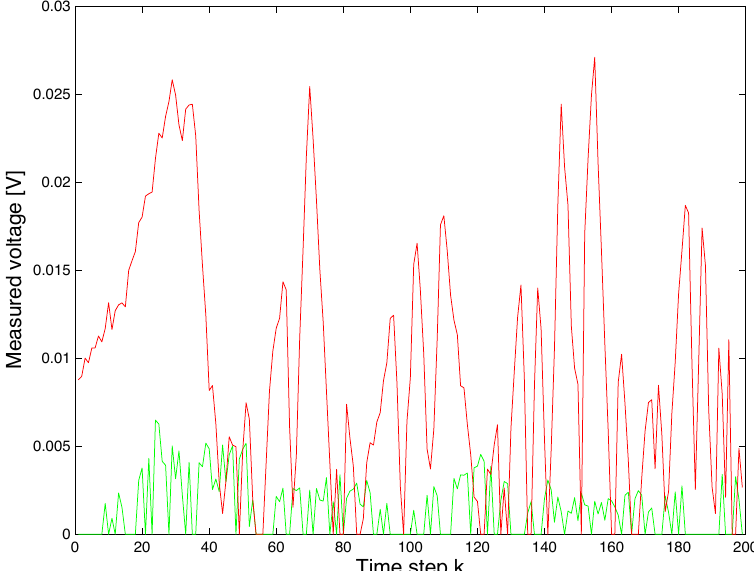
Figure 11. Plot illustrating the minimum voltage that was experimentally measured along the path in a set of 199 positions inside the test area. The green line is obtained using the initial orientation of transmitter coil a = 0, b = 0 and c = 1 and the red line using the initial orientation a = 0.72361, b = − 0.52573 and c =